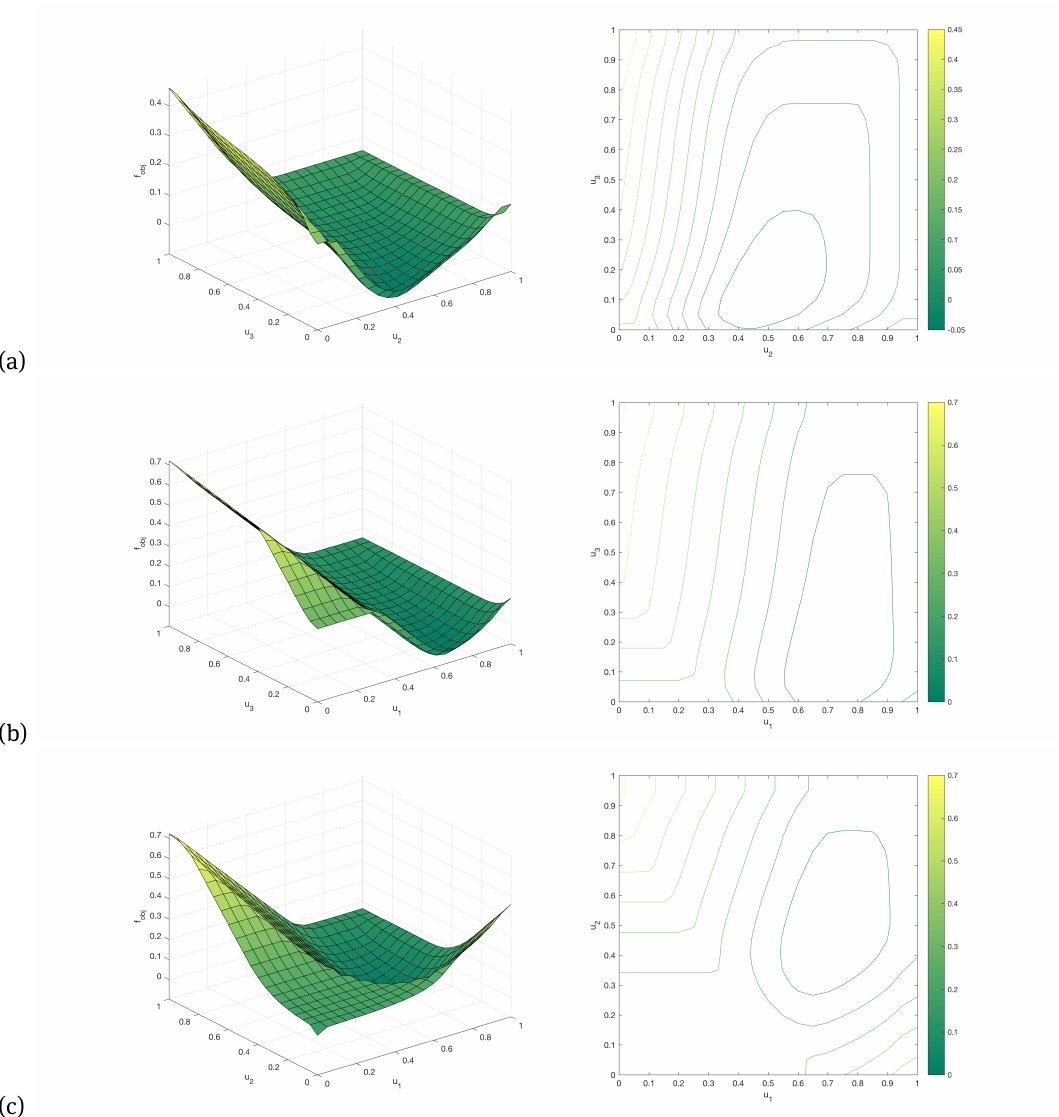
Figure 3: Values and contour plots of the objective function f obj for p = (3.5, 6) and for the marginals restricted on (a) u 1 = 0.7 , (b) u 2 = 0.5 , (c) u 3 = 0.1 ; Setting